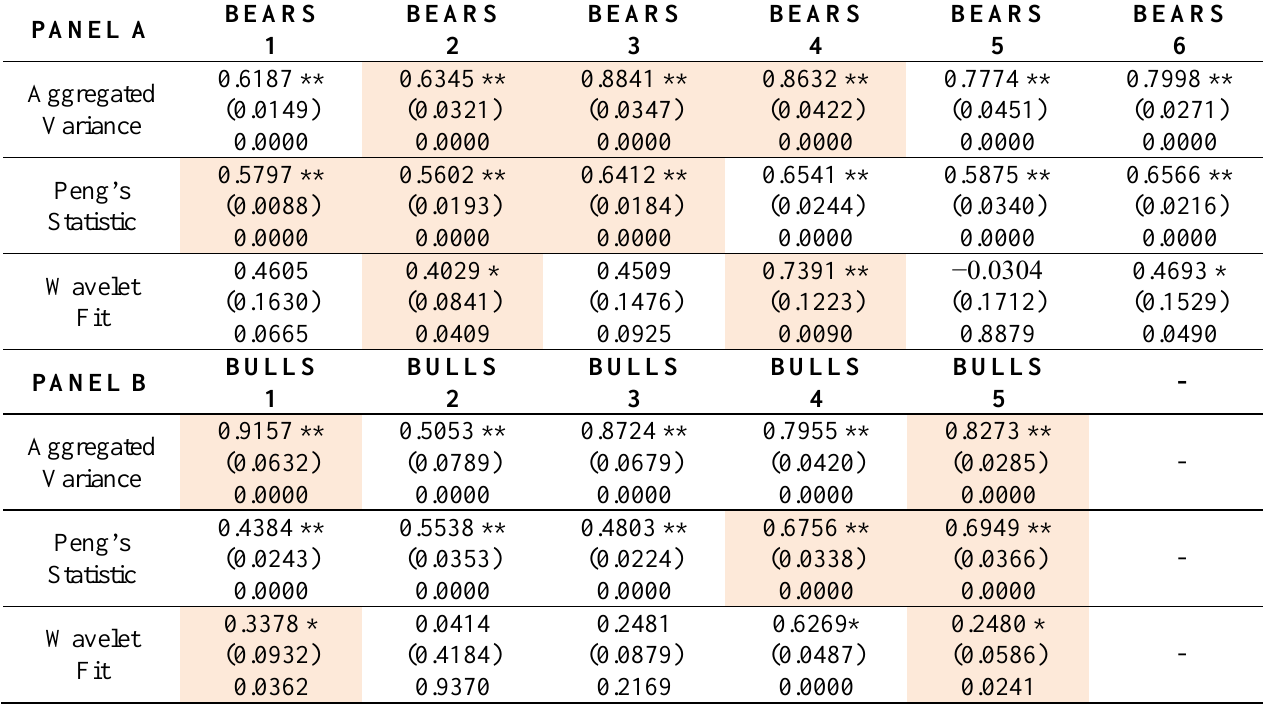
Table 8. Scaling exponent